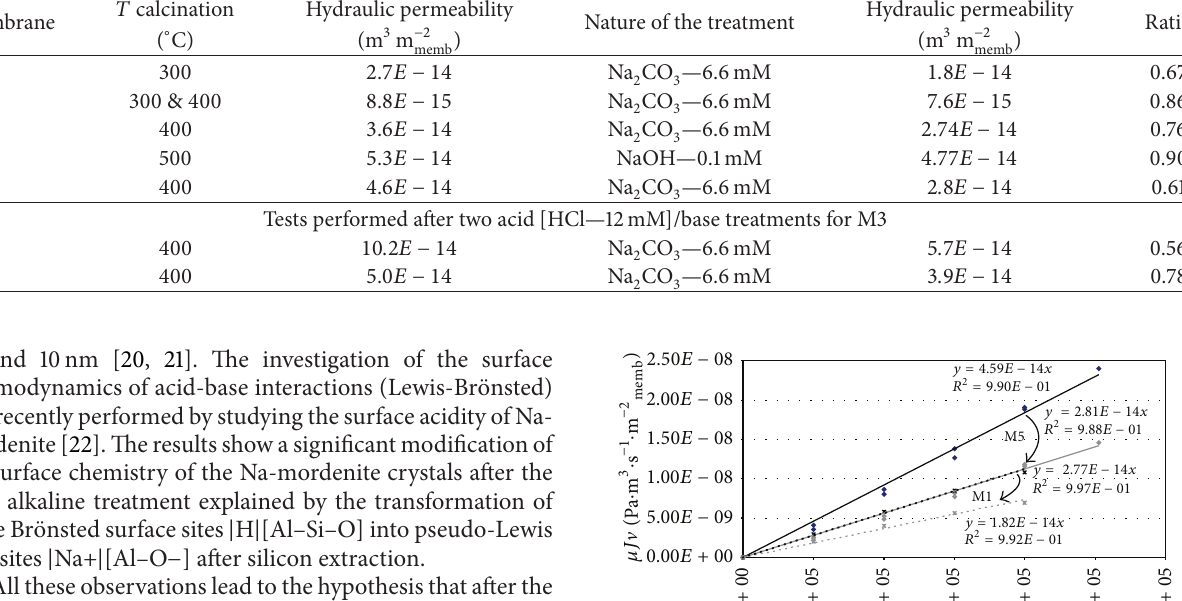
Table 1: Evaluation of the hydraulic permeability from pure water filtration tests performed before and after an alkaline treatment. 𝑇 calcination Hydraulic permeability Membrane